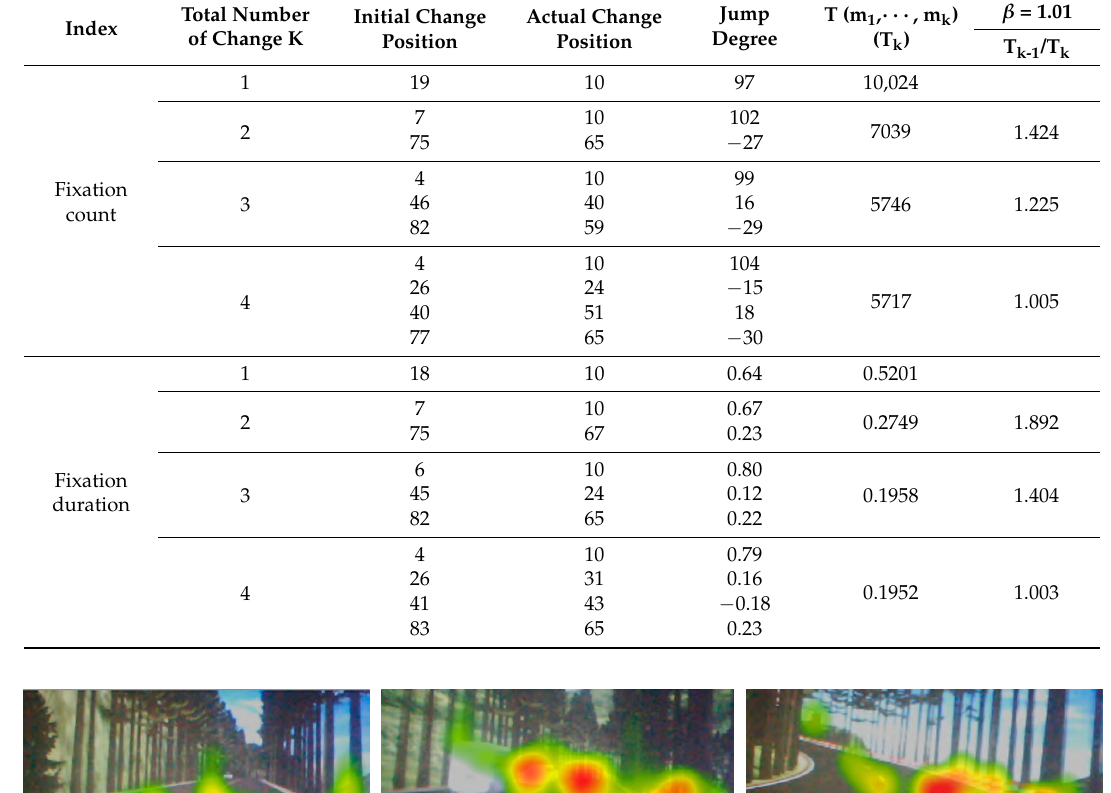
Table 6. The change-point search results by the least squares method.